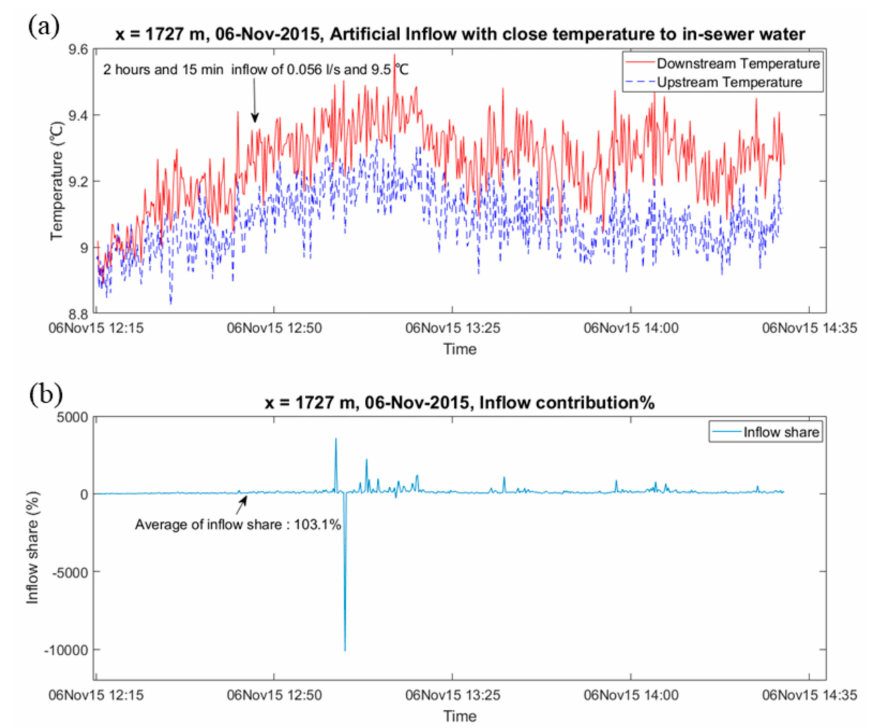
Figure 7. ( a ) Upstream and downstream temperatures on 6 November 2015 around artificial discharge with close temperature of in-sewer water in x = 1727 m; ( b ) percentage of inflow share in comparison with the upstream